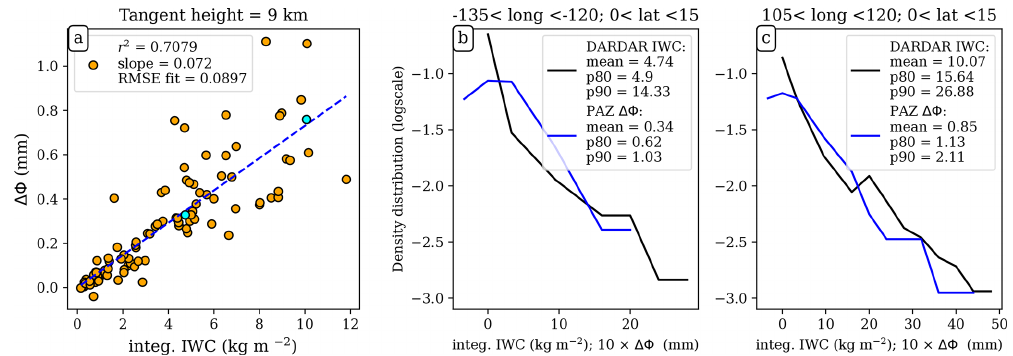
Figure 5. Panel (a) shows the scatterplot of the mean climatologies of CloudSat-RO-integrated IWC vs. the PAZ (cid:49)(cid:56) obtained at the same grid cell, for the data corresponding to a tangent height of 9km and over tropical ocean. Therefore, it is the comparison between the tropical ocean cells in Figs. 4b and 2a. Panels (b) and (c) show the distribution of CloudSat-RO-integrated IWC (black) and PAZ (cid:49)(cid:56) (blue) for two different grid cells at a tangent height of 9km. The grid cells correspond to the two cyan points in panel (a) , and its location is identified in the panel title, with the corresponding longitude and latitude ranges.